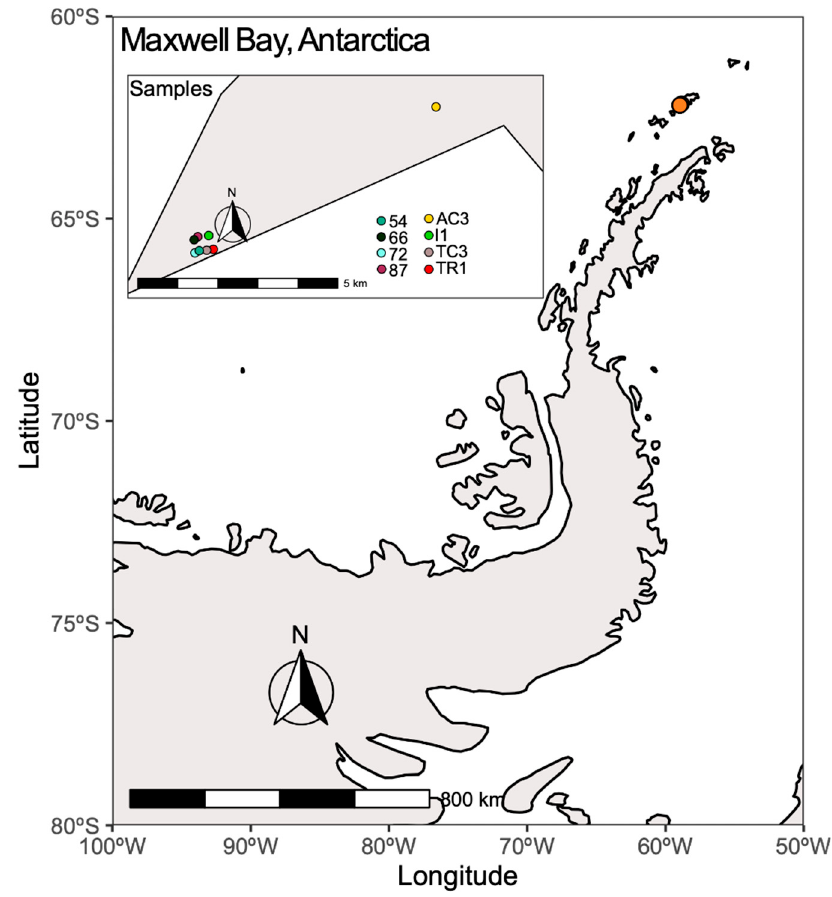
Figure 1. Location of sampling points in Maxwell Bay. This map was created using R v. 3.6.1 [26], R